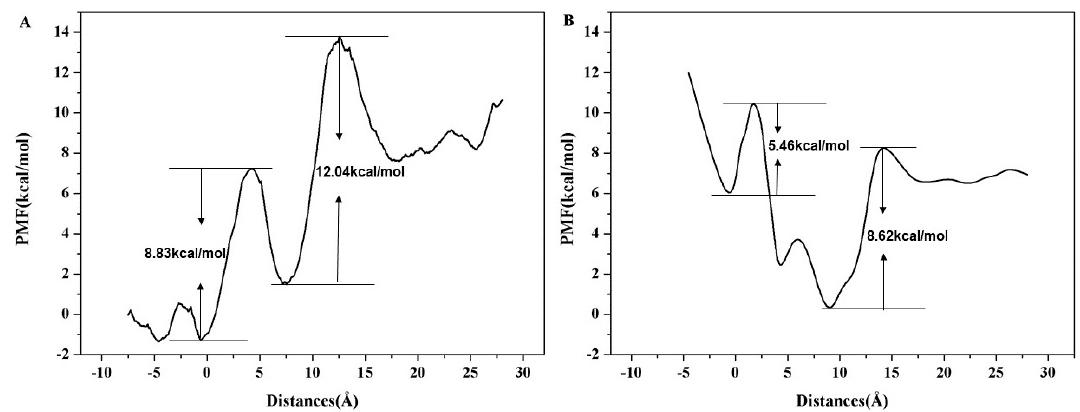
Figure 10. ( A ) PMF reconstructed used the Jarzynski equality and SMD trajectory for Na + permeation across ions channel in ChR2-cis system. ( B ) PMF reconstructed use umbrella sampling for Na + permeation across ions channel in ChR2-cis system.